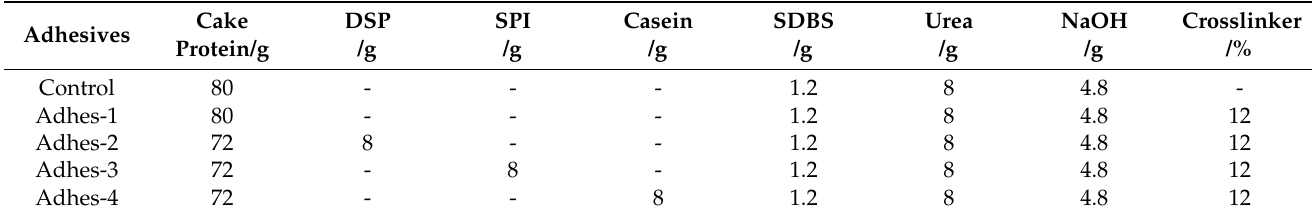
Table 1. The formulation of